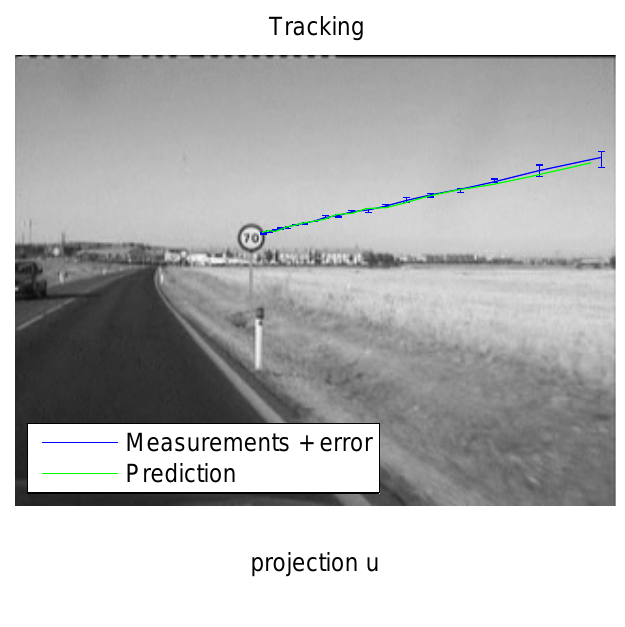
Figure 9. Measurements and prediction obtained during a tracking of a sign. Tracking